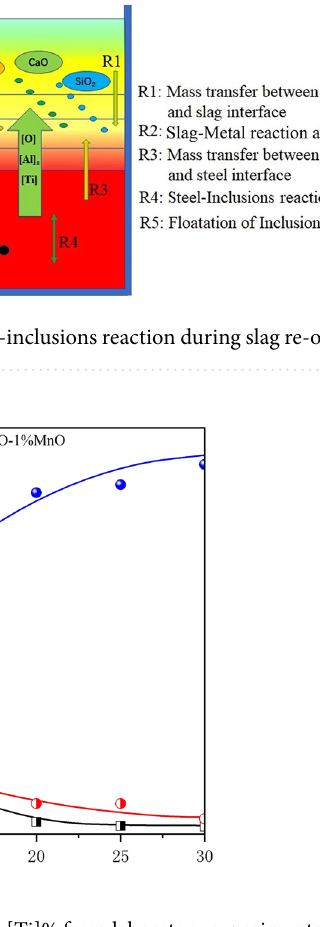
Figure 4. Measured w [Si]%, w [Al]%, and w [Ti]% from laboratory experiments compared with modeled value for m steel = 1.25 × 10 − 5 m 3